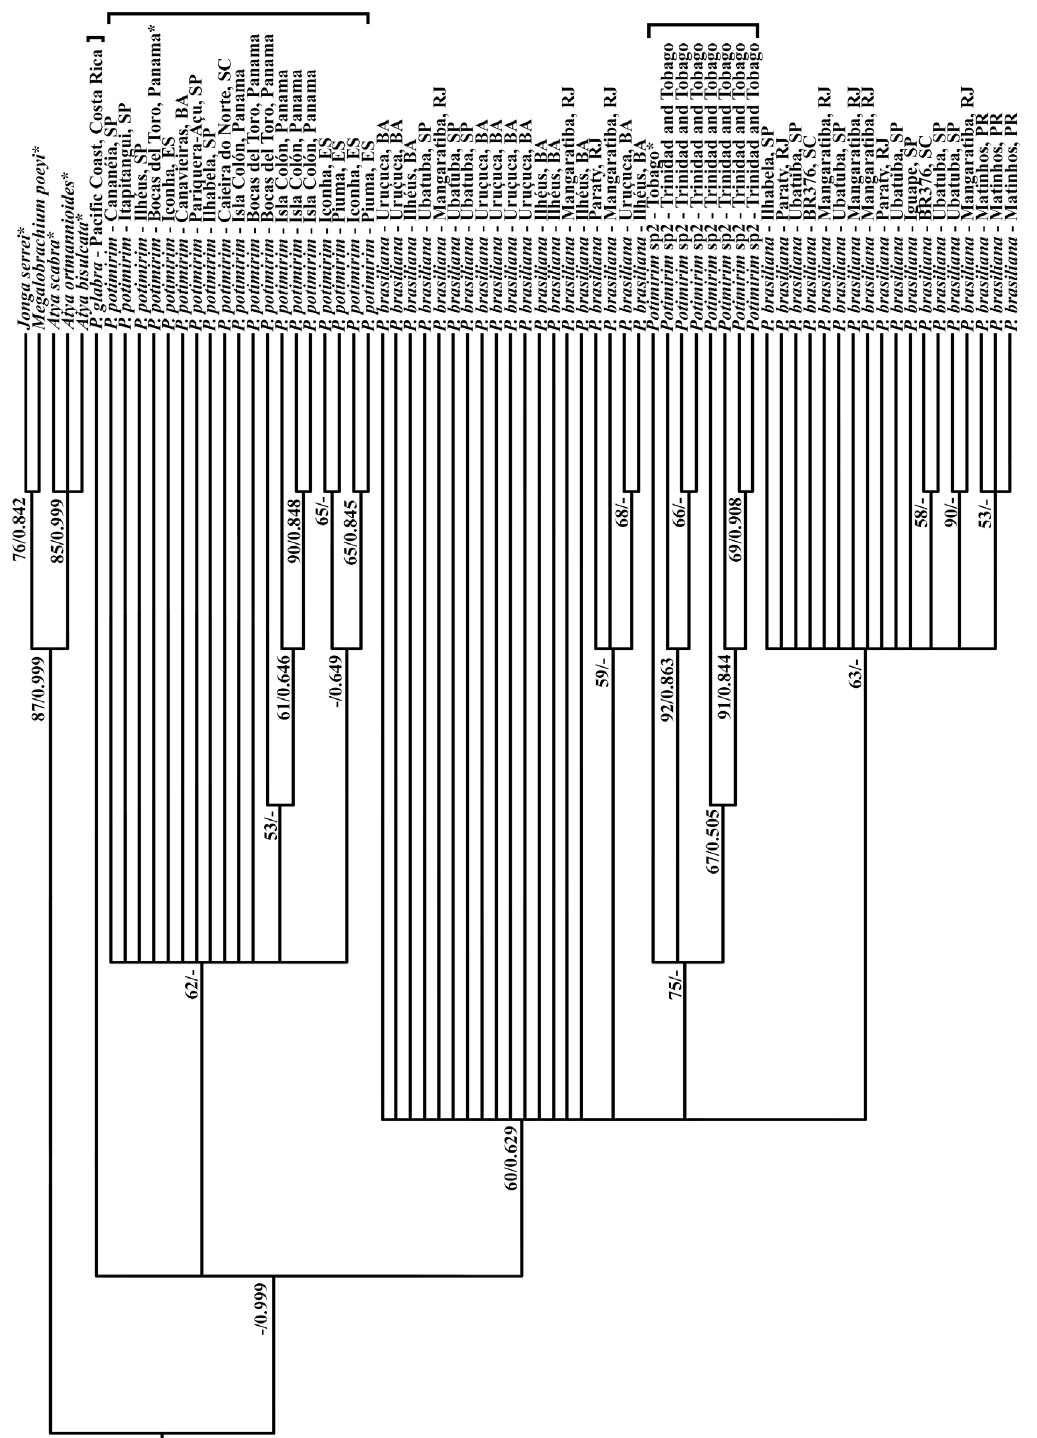
Figure 1. Consensus tree between the maximum likelihood and Bayesian inference based on the concatenate matrix of COI and 28S. Node numbers represent the bootstrap values and a posteriori probability. *Sequence from GenBank. Brackets show Potimirim species that were retrieved as monophyletic groups by the analysis. BA